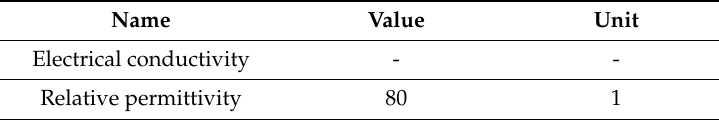
Table 2. Material parameters for water void [6].